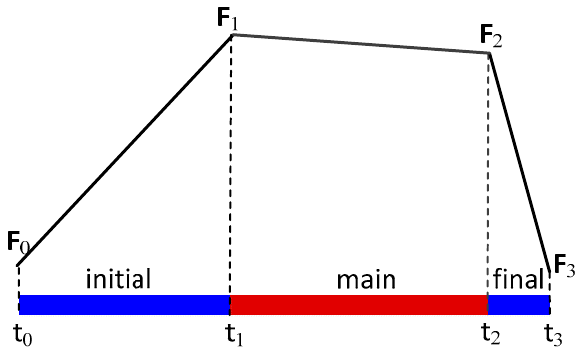
Figure 1. Three stages of satellite maneuver.